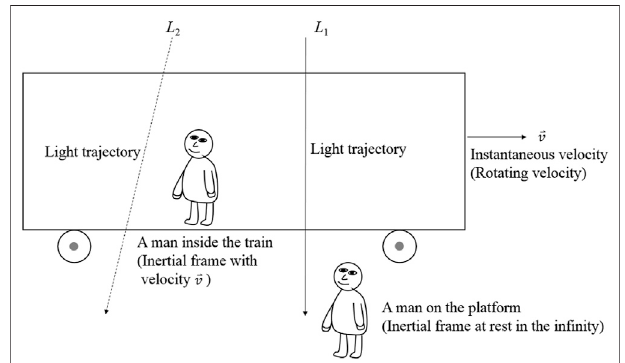
FIGURE 1 | Observations of the light trajectory from different inertial frames.Aninertialframe,thetransparenttrain,has thetangential velocity v the same as the rotating velocity of the Kerr – Newman black hole. An observer stays on the train, and the other one is at rest on the platform. This observer on the platform is in the inertial frame far away from the black hole. A light beam observed by the observer on the platform is perpendicular to the movementofthetrainasthelighttrajectory L 1 wherenodragging-frameeffect exists. The same light beam observed by the observer moving with the train is the light trajectory L 2